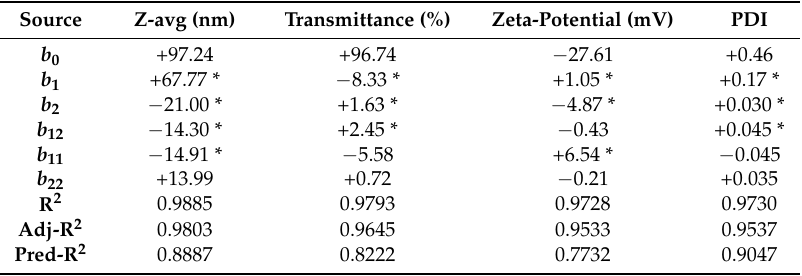
Table 2. Summary of results of regression analysis for responses Z-avg, Transmittance, Zeta-potential, and PDI with R 2 , Adj-R 2 , and Pred-R 2 tests (statistical significance indicated by * ( p <